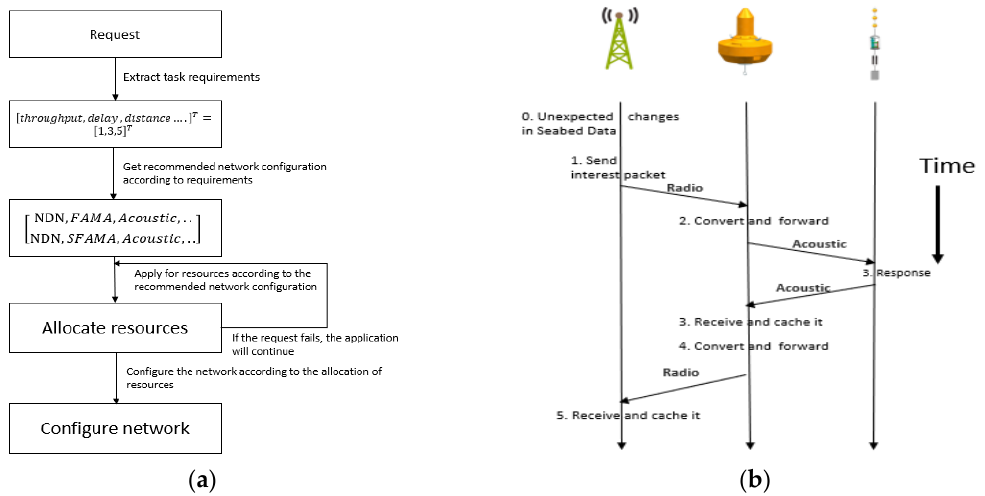
Figure 15. ( a ) Emergency data request for underwater detection application; ( b ) detailed information of interaction between emergency task terminals of underwater environmental monitoring network.